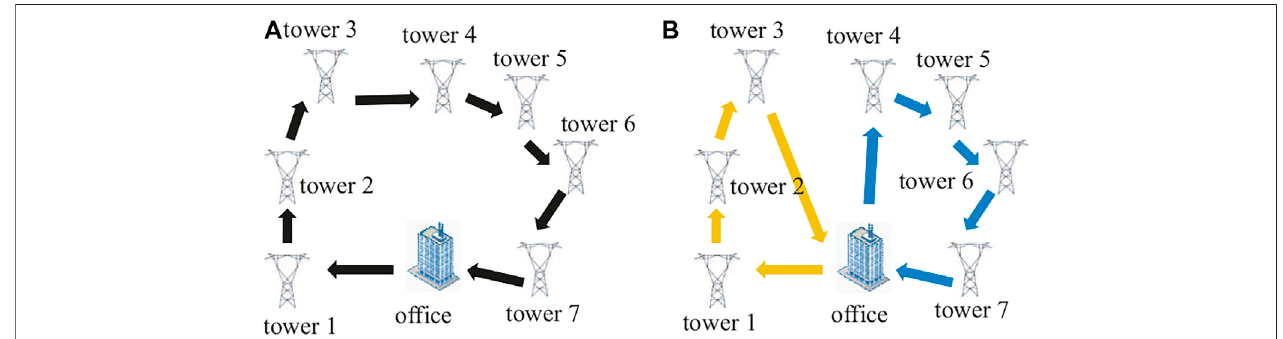
FIGURE 1 | (color online) A simple example about path planning with one of fi ce and seven towers. (A) Optimal path for one inspection team to complete a given inspectiontask. The total workinghours (spending time)isthedrivingtime ofthe path plus theinspectiontime by UAVs,robots,or workers, thatis, t d + 7 t ins . (B) Optimal path that balances theworking hoursbetweenthe twoinspectionteams. Theworkinghours is t 1 wh and t 2 wh forthe twoinspectionteams. Thedifference ofworkinghours between the tow inspection teams is t diff (cid:1)| t 1 wh − t 2 wh | , where | ·| is the absolute value of · .